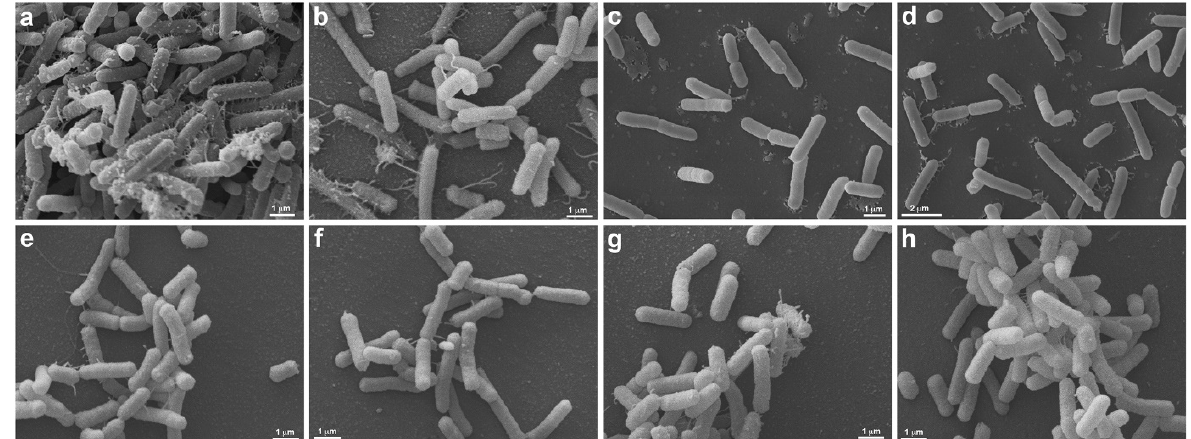
Figure 6. Morphological analysis of UV ‐ C treatment (2 s) by Scanning Electron Microscopy. S. en ‐